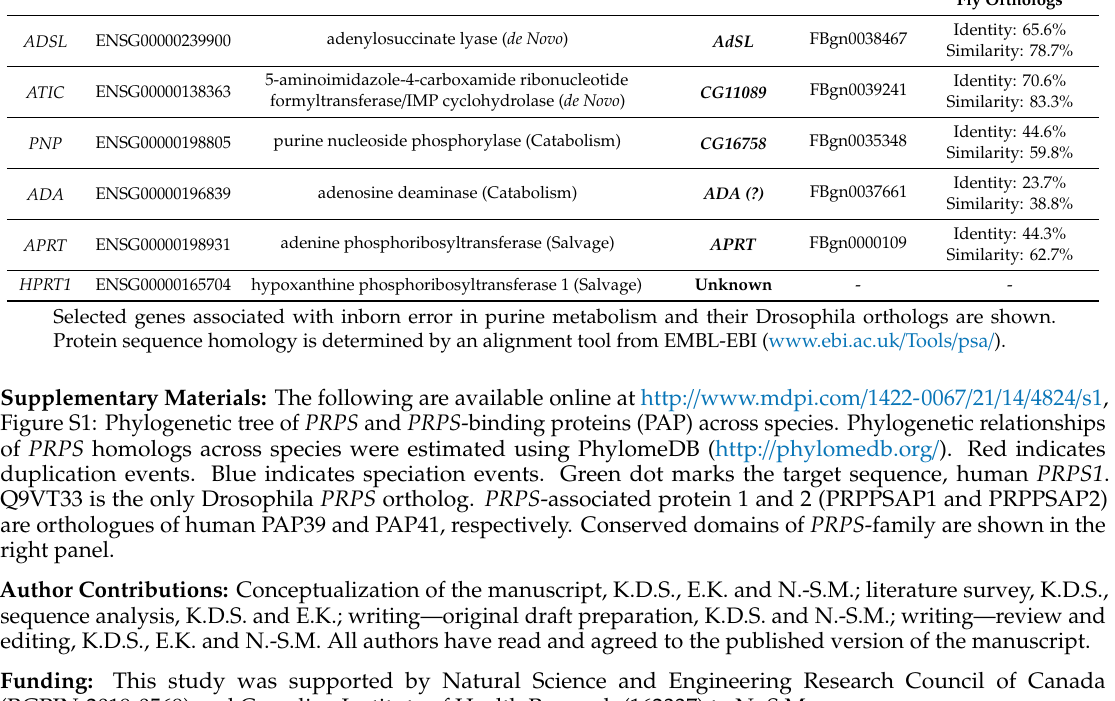
Table 3. Genes causing inborn errors in purine metabolism.